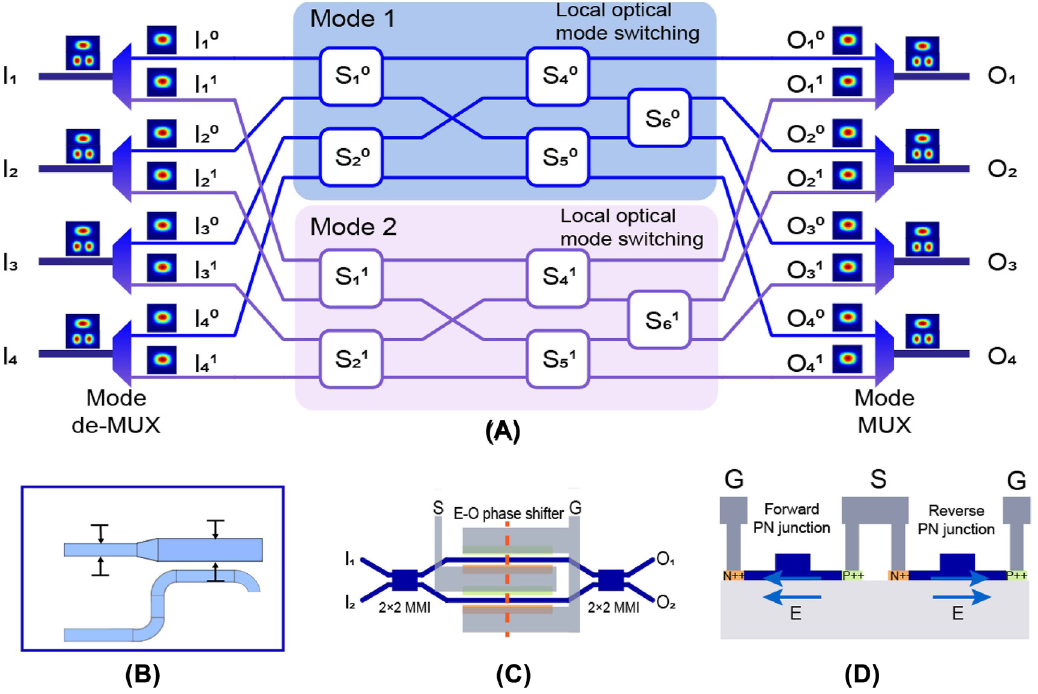
Figure 2: The dual-mode 4 × 4 optical switch. (A) Main schematic. (B) Mode multiplexer based on asymmetric directional coupler. (C) Signal-mode 2 × 2 EO switch unit with push–pull drive. (D) The cross section at the red line of (C). the recombination between different spatial mode chan- nels. Therefore, A total of 576 (4! × 4! = 576) routing states can be achieved by this dual-mode 4 × 4 optical